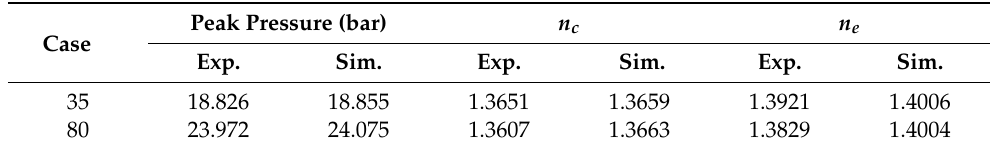
Table 6. Comparison of peak in-cylinder pressures and estimated polytropic coefficients for the experimental and numerical compression and expansion phases.